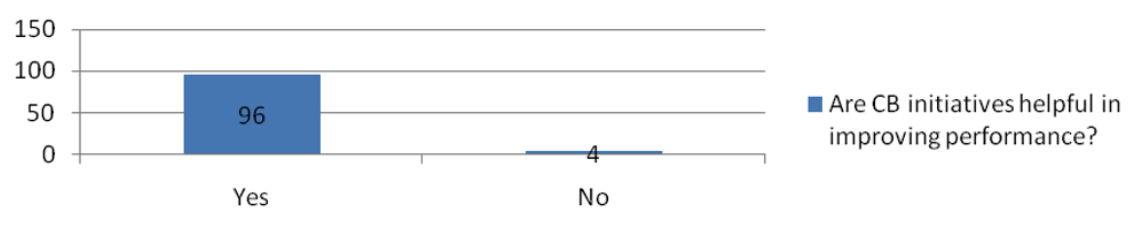
Figure 8: CB initiatives helpful in improving